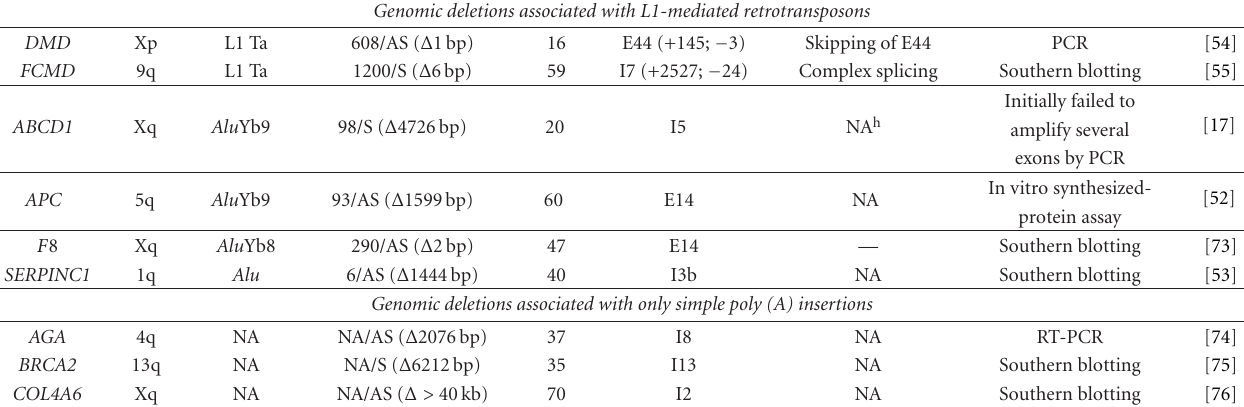
Genomic deletions associated with L1-mediated